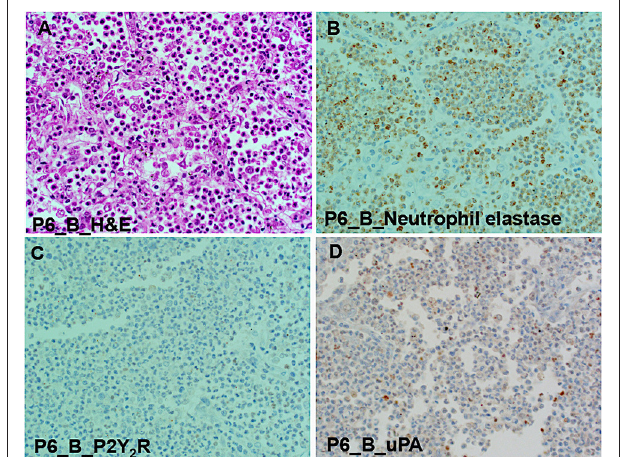
FIGURE 8 | Immunohistologic examination of lobar pneumonia patient (case P6 Block B) shows strong staining for neutrophil elastase, but poor staining for P2Y 2 R and uPA. (A) Micrograph of lung tissue stained with hematoxylin and eosin (H&E) showing numerous neutrophils congest alveolar space and relatively few macrophages and lymphocytes. (B) Intense staining for polymorphonuclear (PMN) leukocytes with antibodies against neutrophil elastase (Abcam ab68672). (C) Weak staining for P2Y 2 R expression (H70 antibody: SC-20124), deficiency of P2Y 2 R is agreement with low P2Y 2 R (TaqMan measurement). (D) Weak staining for uPA is correlated to low macrophage